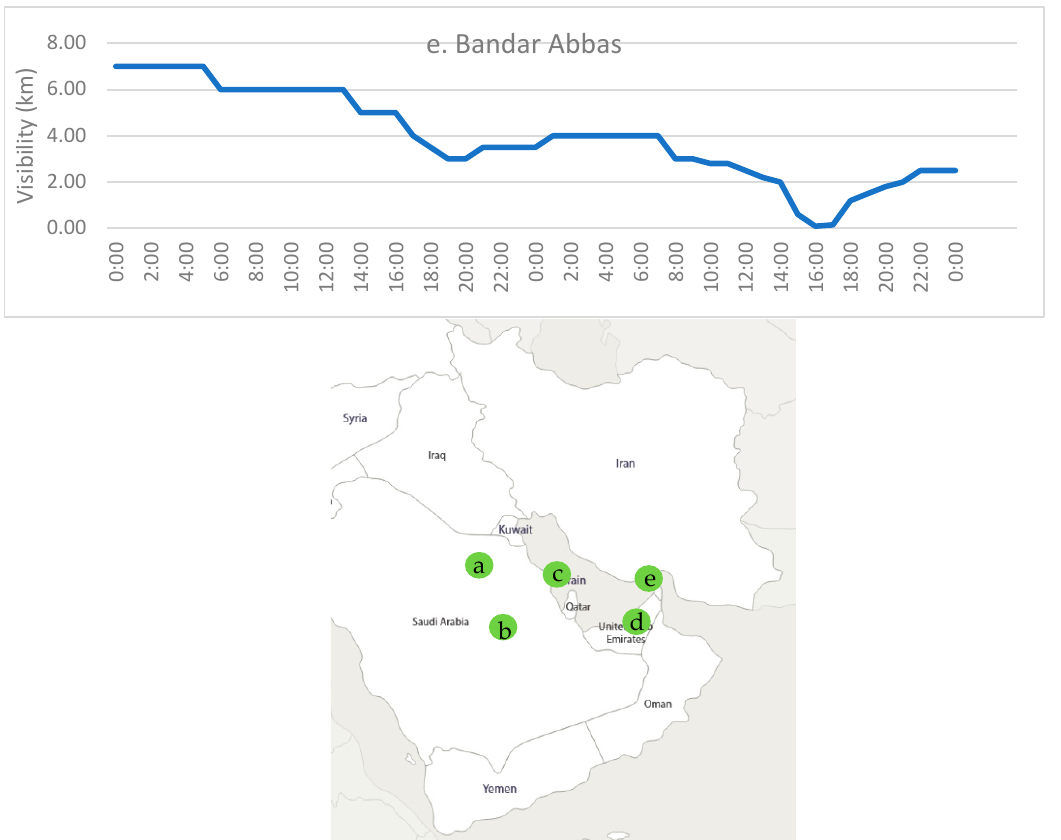
Figure 7. Variation in visibility reported at five airports, 1–2 April 2015, compiled from daily METAR reports. An indication of how flight schedules were affected by the dust storm is given in